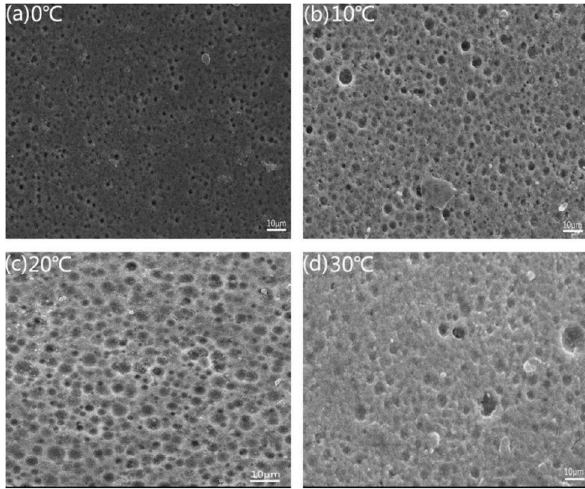
Figure 8: XRD pattern of spanner surface before and after anodic